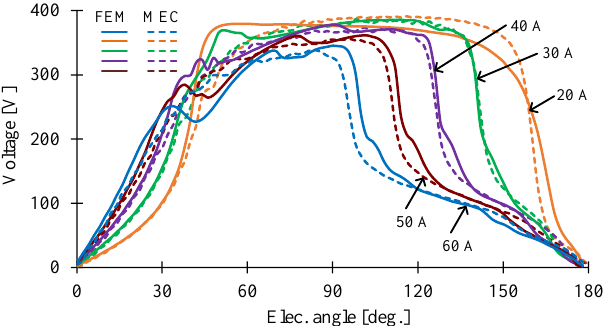
Figure 17. Static phase voltage characteristics at 5450 r/min at different currents.